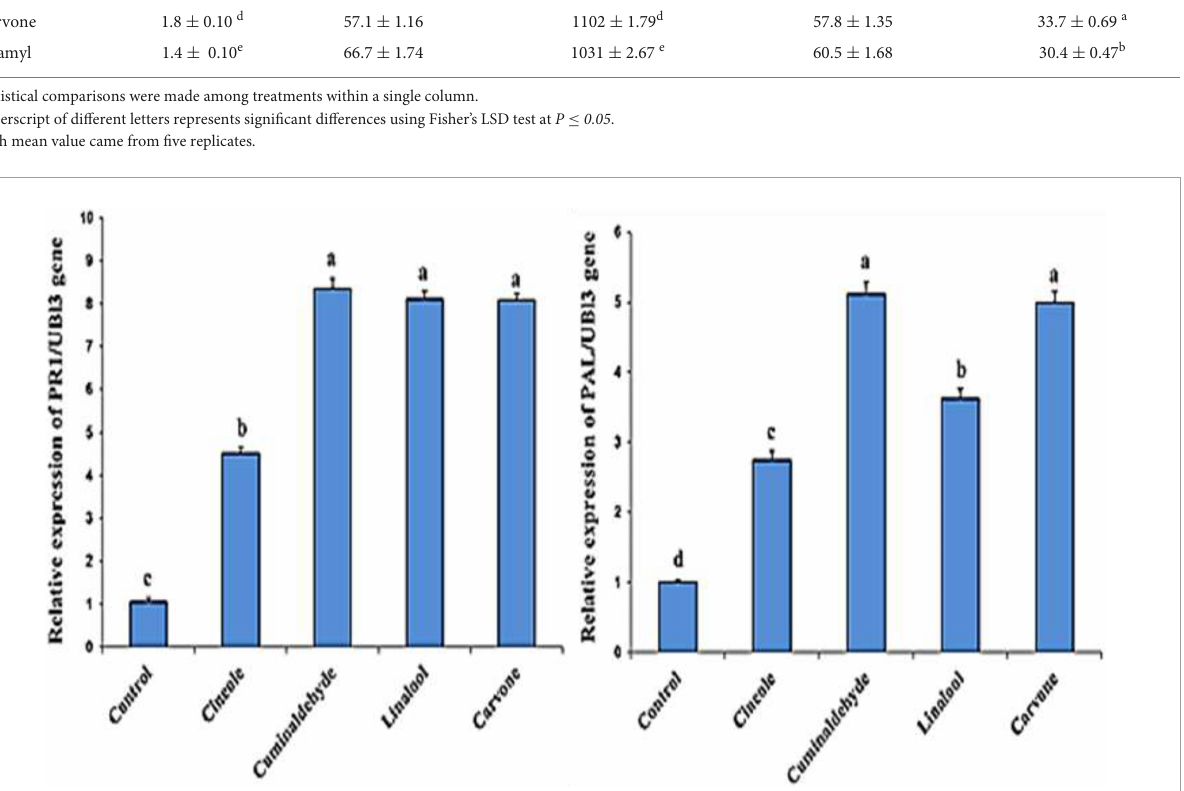
FIGURE2 Effect of different treatments on the expression levels of PR1 and PAL genes. Columns represent mean values. The control corresponds to inoculated and non-treated plants. Bars indicate standard errors. Different letters above columns indicate significant differences by Fisher’s LSD test at significant values of P ≤ 0.5